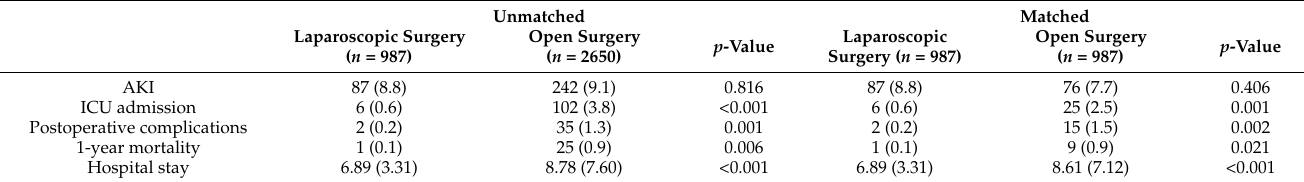
Table 2. Surgical outcomes in the unmatched and matched samples.